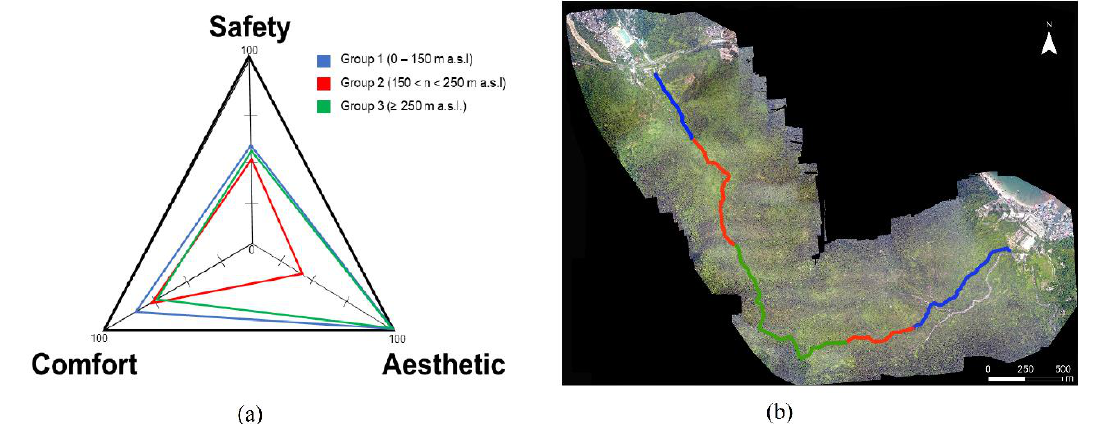
Figure 2. A visual-based analysis carried out to display the distribution of strength between the three groups based on safety (trail condition), comfort (canopy cover) and aesthetic (phytotourism products and scenic spots) at three di ff erent altitude groups of the study site. ( a ) Strength distribution plot for the three major elements in developing a hiking trail, namely safety, comfort, and aesthetic, as proposed in this study for the three sampling point groups. ( b ) Trail is classified into three groups based on altitude. The legend indicates the color code for the results for each group.